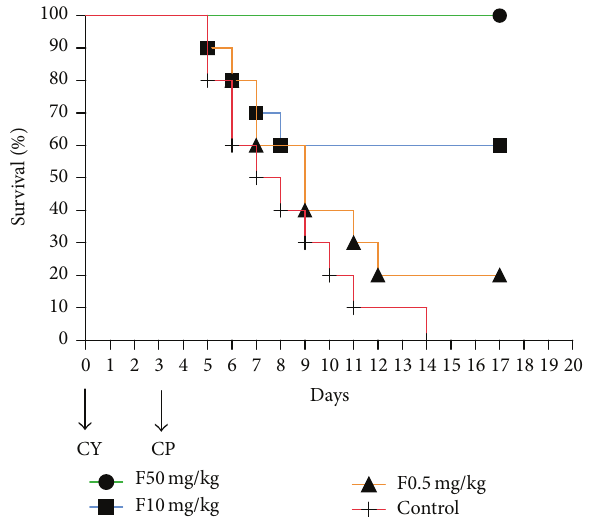
Figure 8: Survival curves of fluconazole treated mice ( 𝑛 = 10 per group). Comparisons between each two groups except 0.5 and 10mg/kg/d groups that showed significant differences ( Log-rank Test, 𝑃 < 0.05 ).